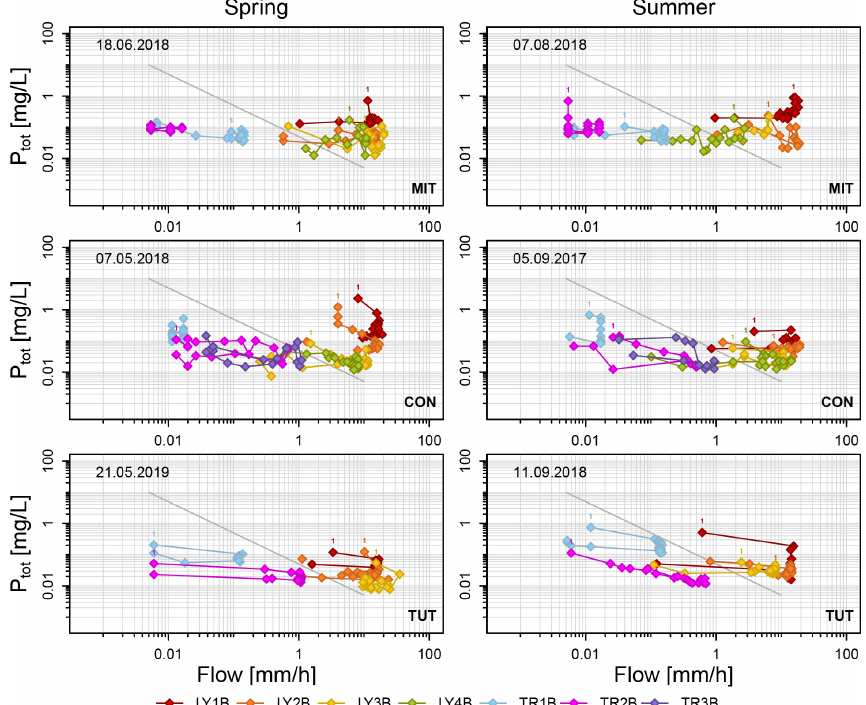
Figure 6. P tot concentrations as a function of subsurface flow in the lysimeters (LYs) and the trenches (TRs) during the sprinkling experiments in Mitterfels (MIT), Conventwald (CON) and Tuttlingen (TUT). The diagonal gray line indicates simple dilution ( C ∼ 1 /Q ). Label “1” indicates the first data point of each flow